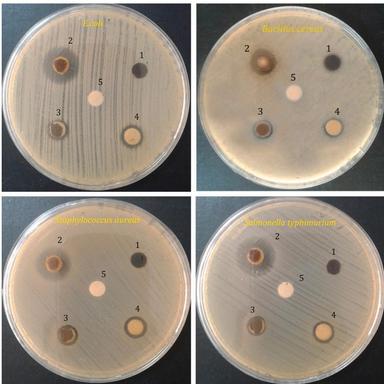
Zone of inhibition 1: Fe3O4, 2: Fe3O4/AHSG/Ag, 3: Fe3O4/AHSG, 4: AgNO3, and 5: distilled water.